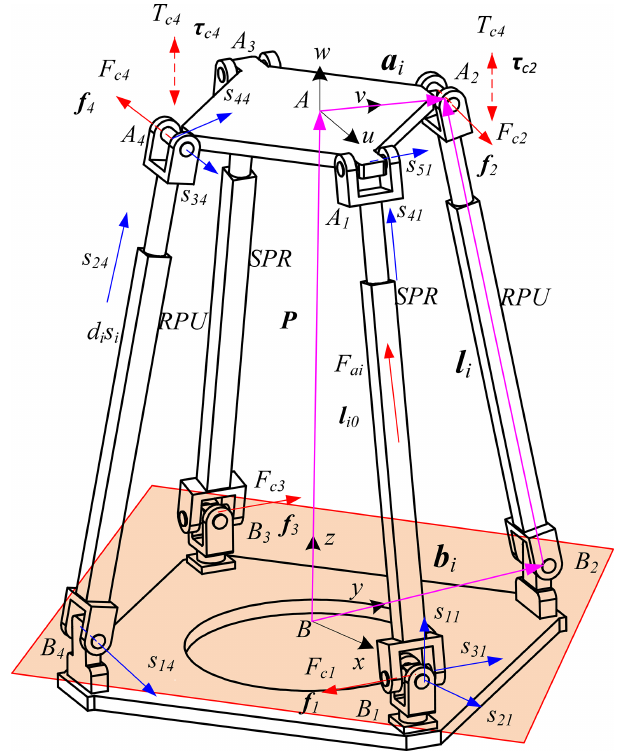
Figure 2. 2RPU-2SPR parallel